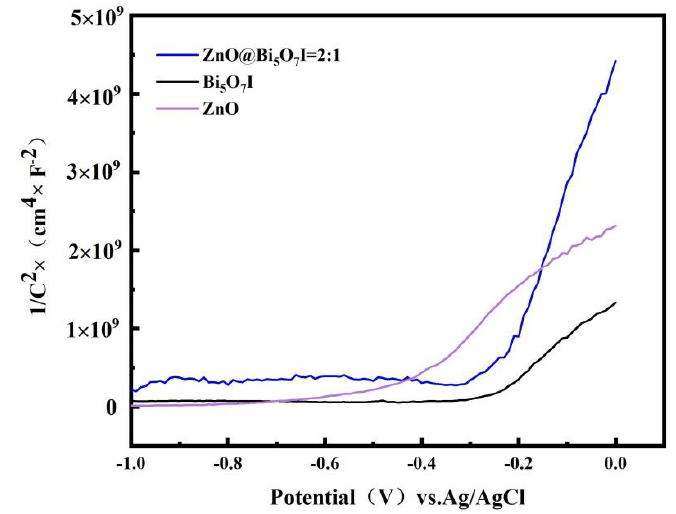
Figure 11. Mott-Schottky curve of Bi 5 O 7 I, ZnO, and ZnO@Bi 5 O 7 I.